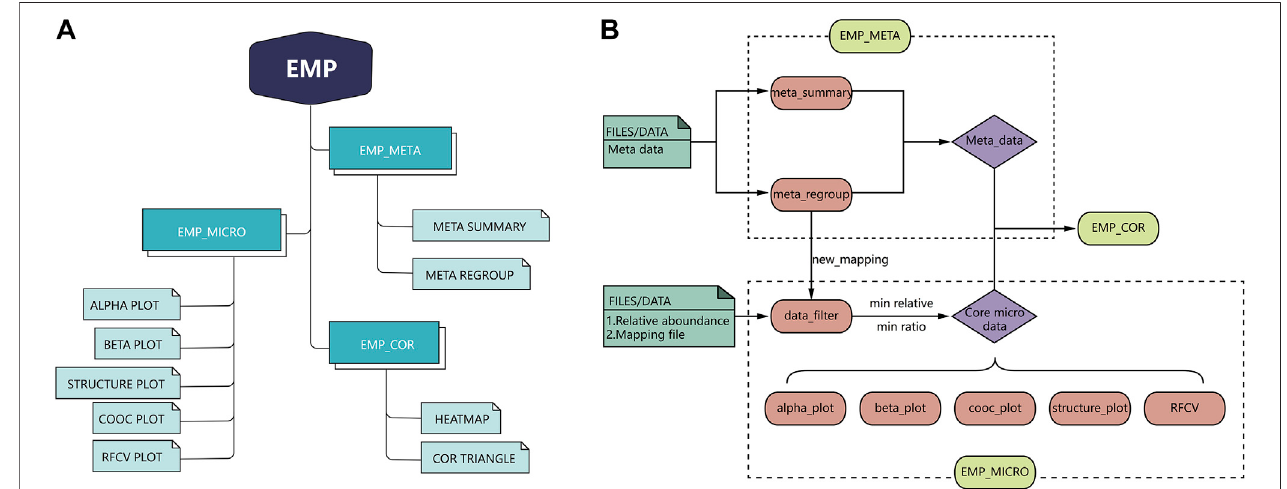
FIGURE 1 | Overall design and work fl ow of EasyMicroPlot